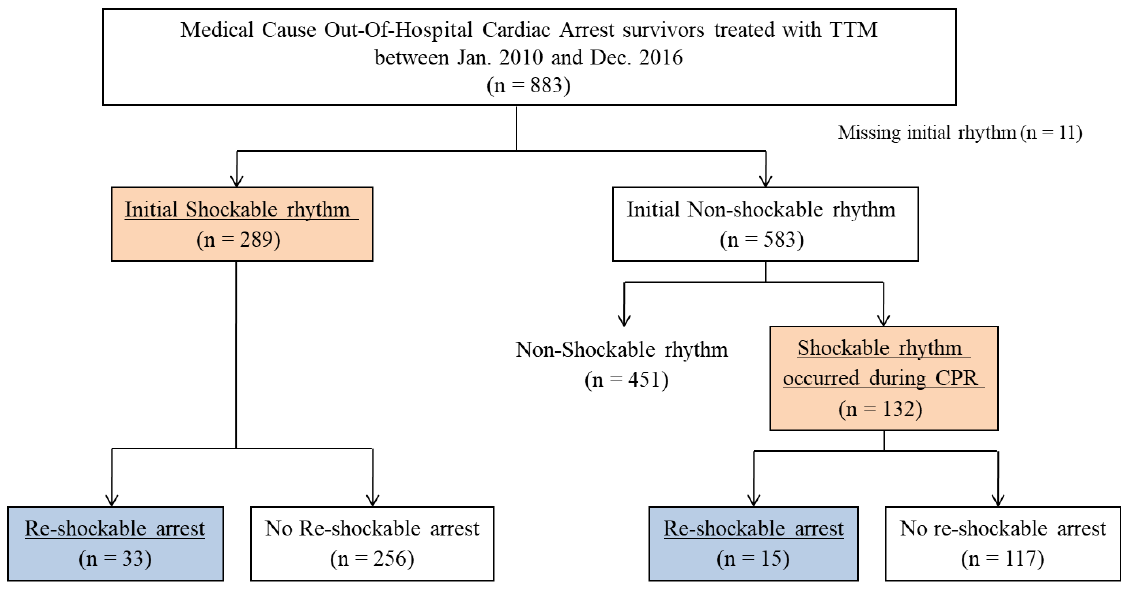
Figure 1. Diagram of the included patients.